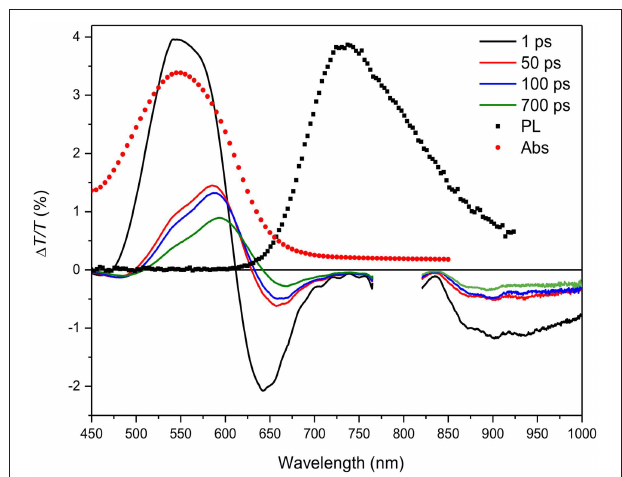
FIGURE 3 | 1 T / T spectra at different probe delays (see legend in the figure) compared to the absorption (Abs, red solid circles) and photoluminescence (PL) emission (black solid squares) spectra for the HMM nanoparticle